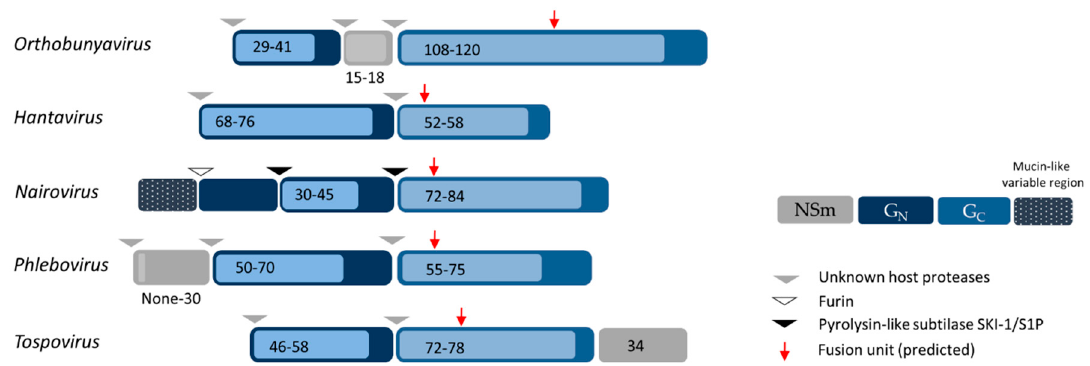
Figure 2. Schematic representation of bunyavirus G N and G C precursor glycoprotein sequences of each genus. Light and dark colored boxes indicate the smallest and highest molecular weight (kDa) of each protein in each genus, respectively. Arrow heads indicate the proteolytic cleavage sites within the glycoprotein precursor by host proteases [32,33]. Red arrows show the localization of the fusion peptide for each genus based on the crystal structure obtained from Rift Valley fever virus Gc [34] and on bioinformatics predictions and biochemical analysis of the glycoproteins from the orthobunyavirus La Crosse, the hantavirus Andes, the nairovirus Crimean ‐ Congo hemorrhagic fever and the tospovirus tomato spotted wilt [35 ‒ 37].